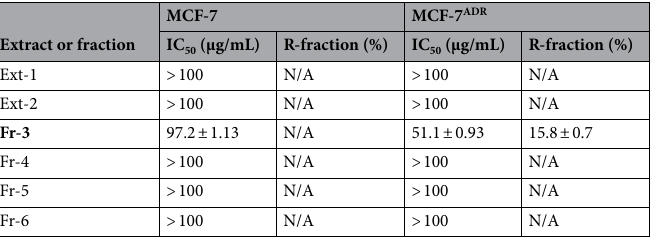
Table 2. Cytotoxic activity of P. niruri of various extracts and fractions against MCF-7 and MCF-7 ADR cell lines. # N/A means not applicable.